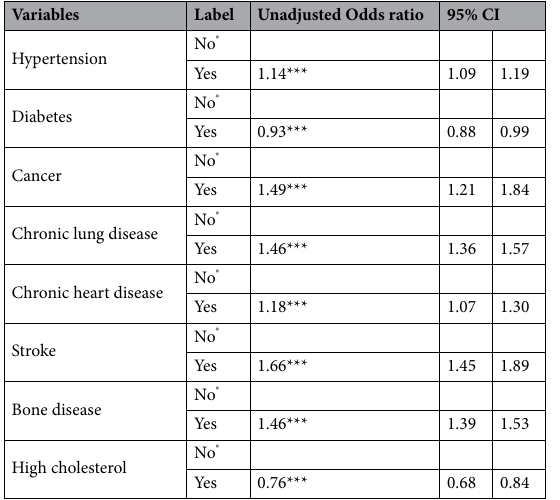
Table 3. Unadjusted Odds ratio and 95% CI for various chronic diseases associated with depressive symptoms among older adults in India (LASI Wave 1, 2017–2018). ® represents reference category. *Represents statistically significant values at 90% CI. **Represents statistically significant values at 95% CI. ***Represents statistically significant values at 99%